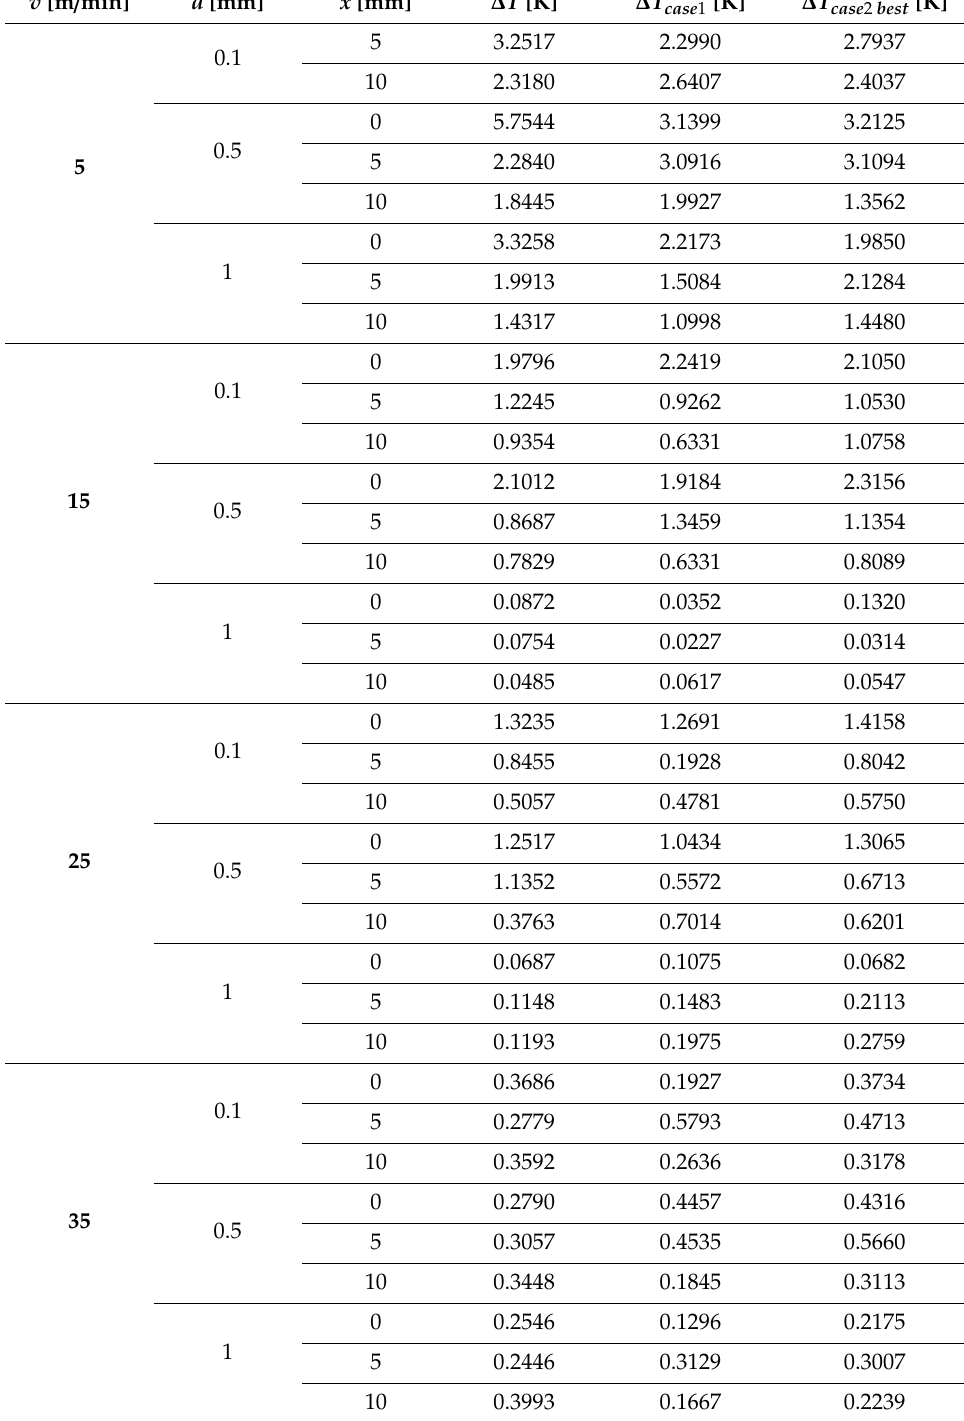
Table 3. Experiment inputs, outputs and predicted output (based on the testing set) of optimized ANFIS and percentage di ff erence between